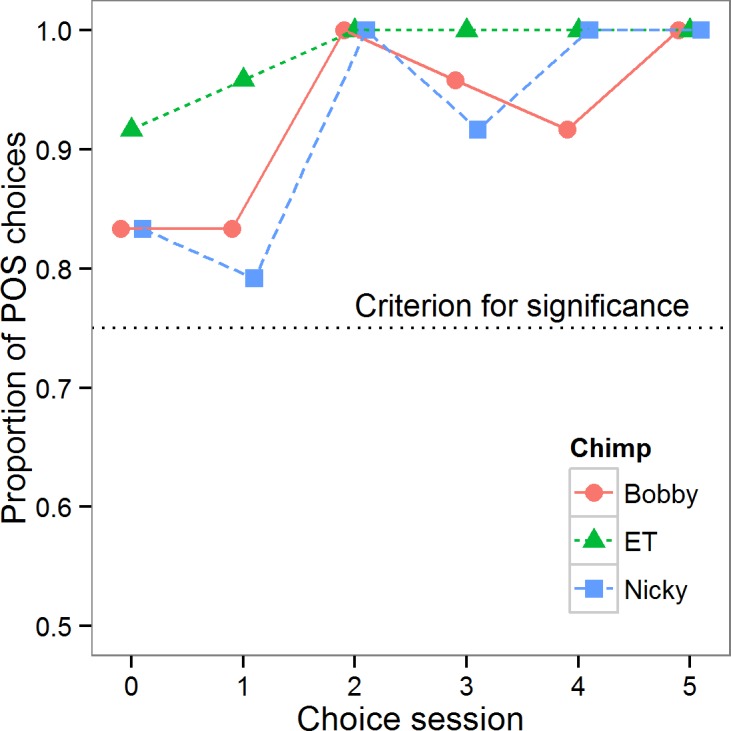
Choice data.Proportion of choices of the POS cone in each choice session for each of the three chimpanzees. The dotted line shows the criterion for choice to be significantly different from random (p < 0.05).